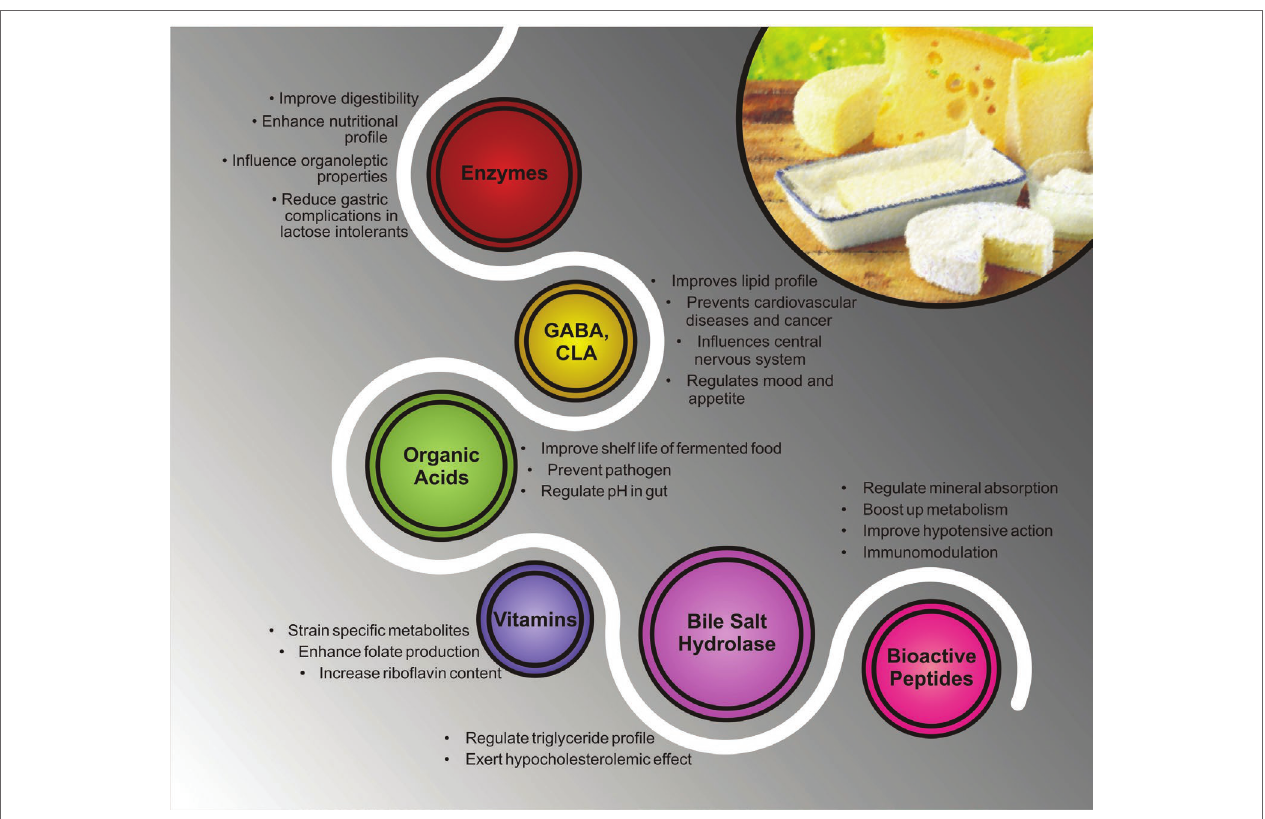
FIGURE 3 | Different health benefits of bioactive metabolites present in ethnic fermented dairy